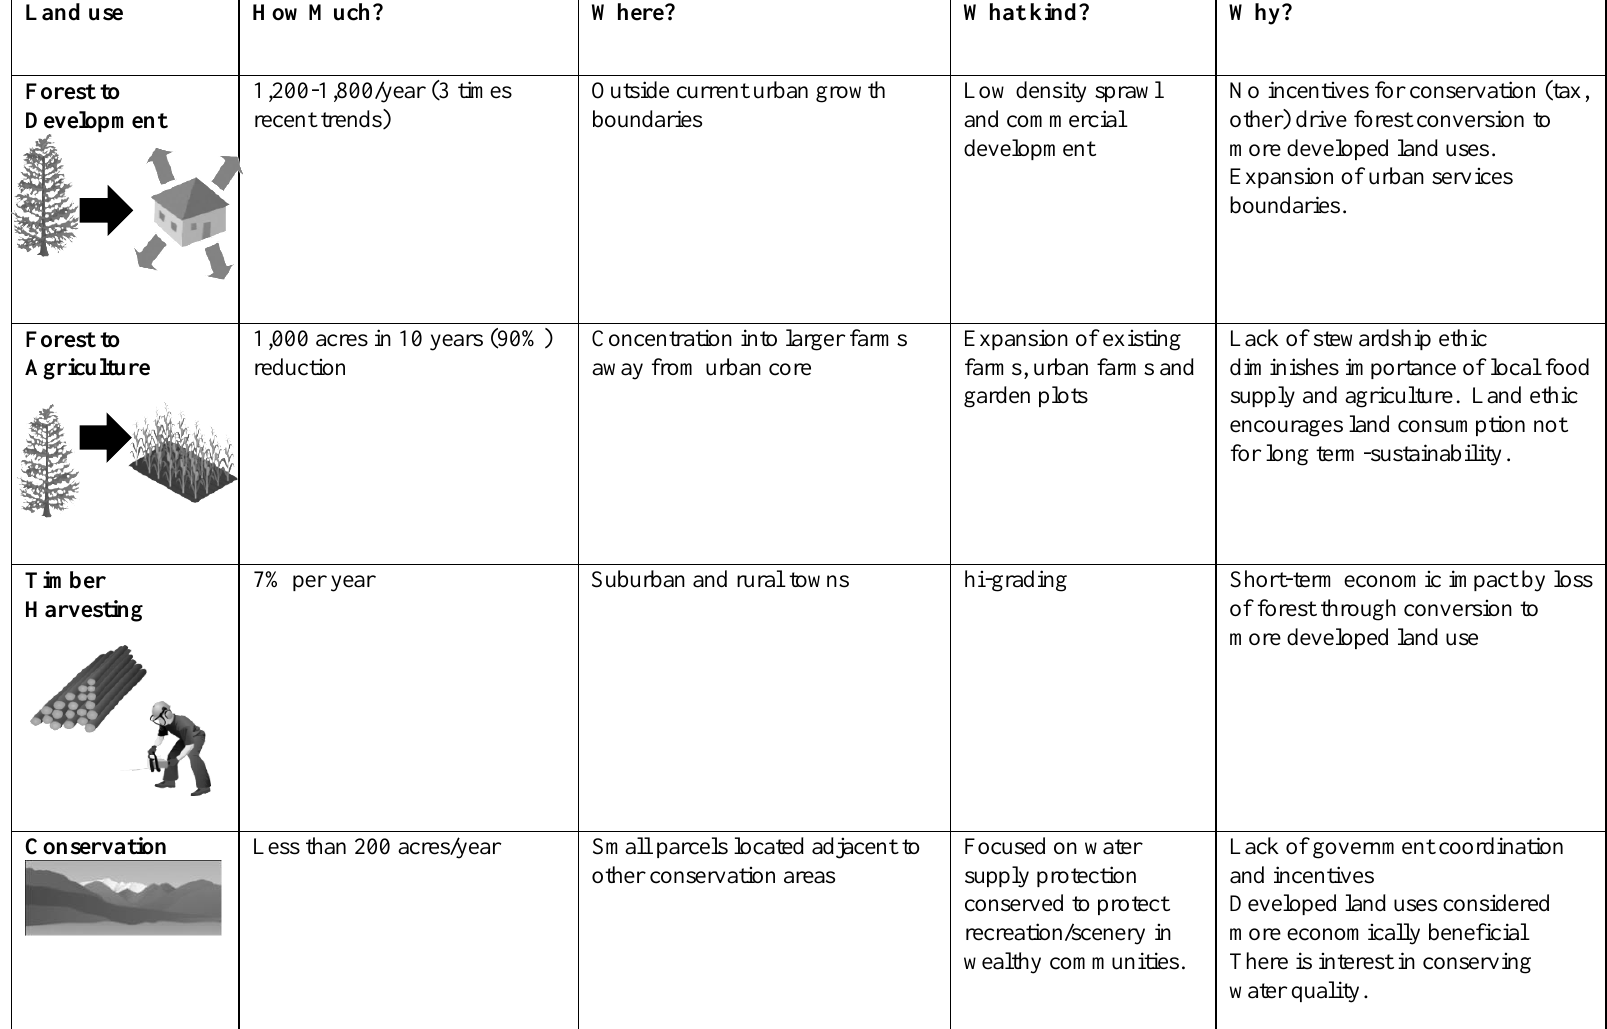
Table A2.19. Scenario 3: I Did It My